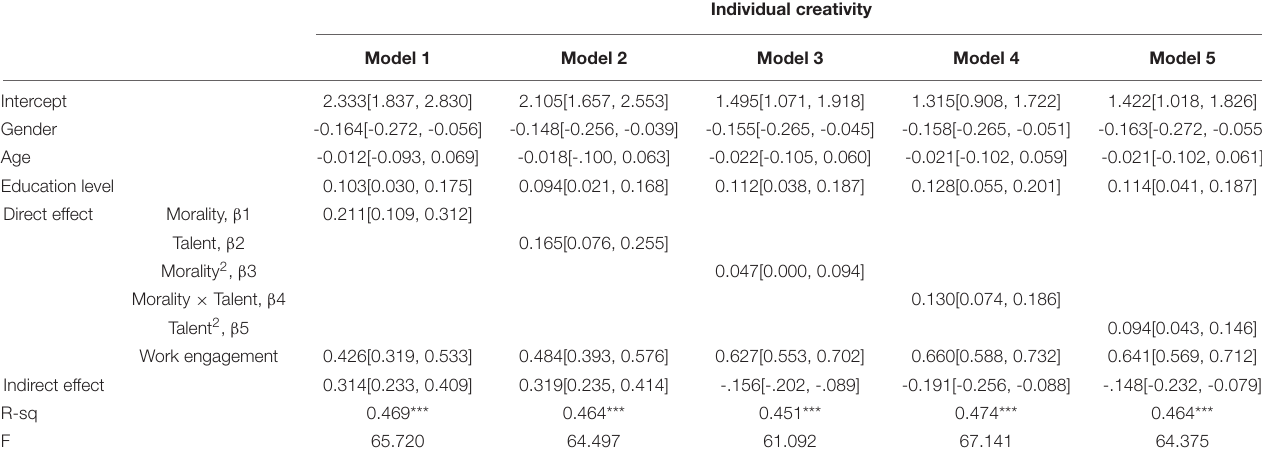
TABLE 4 | Mediating effect of work